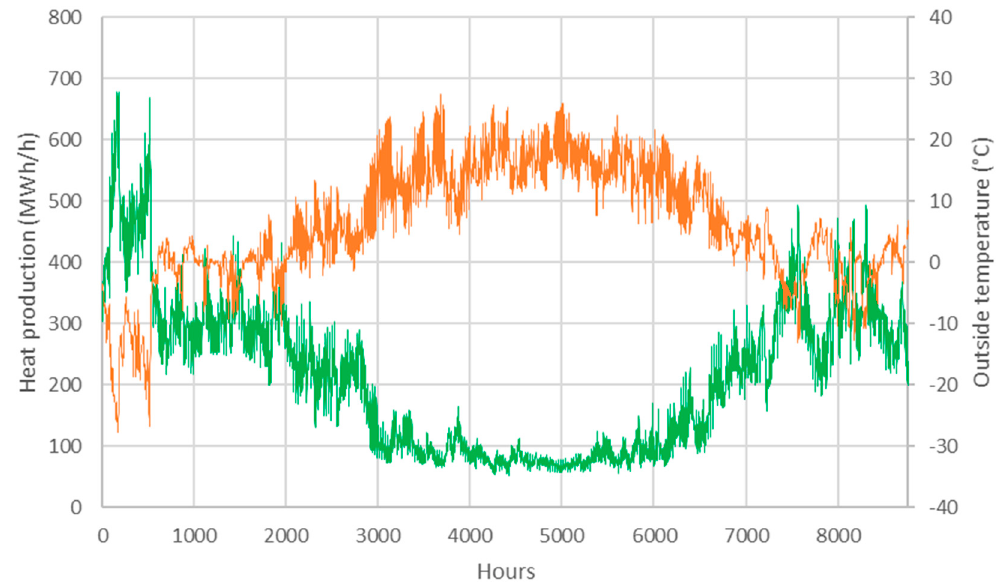
Figure A2. Hourly heat load and outdoor temperature as input values to the simulations.